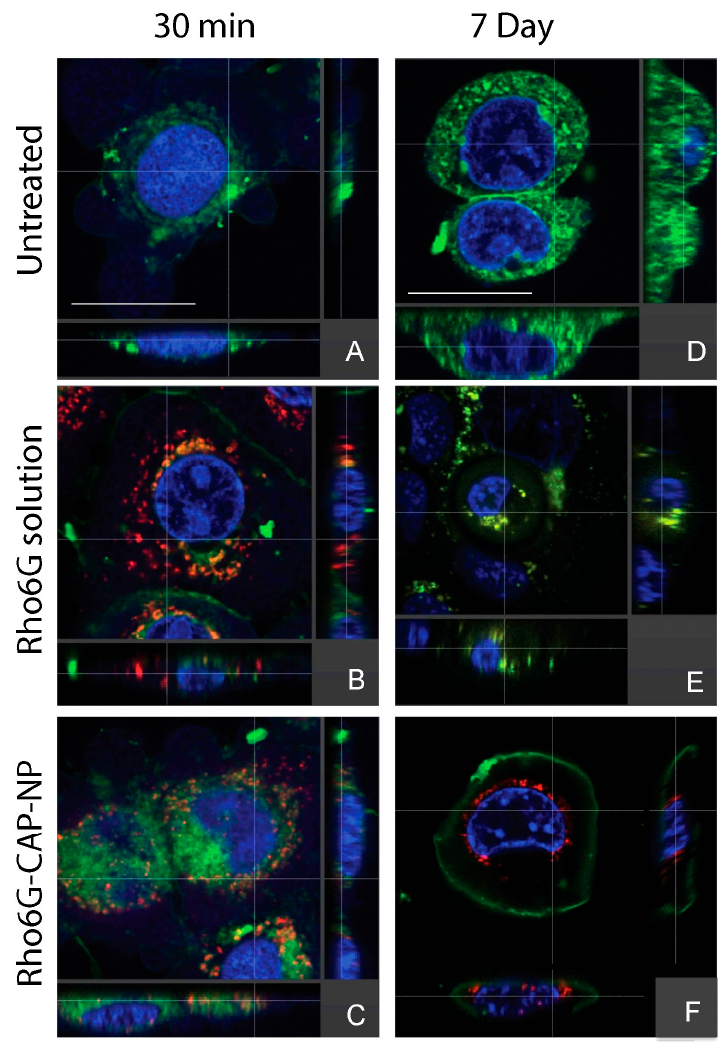
Figure 3. Translocation of Rhod6G Solution or Rhod6G–CAP–NPs to Vaginal Epithelial cells (VK2/E6E7). Rhod6G Solution (red) or Rhod6G–CAP–NPs at: 30 min ( A – C ); and seven days ( D – F ) post-treatment. Orthogonal Plane Images were obtained and evaluated by the IBIF Leica TCS SP8 MP Confocal Microscope at 63 × with 5 × computational magnification. DAPI: blue, DiO: green, Rhodamine: red. ( A )/( D ): Untreated, ( B )/( E ): Rhodamine Solution (1 µ g/mL), ( C )/( F ): Rhod6G–CAP–NPs (1 µ g/mL). Scale bar = 13 µ m and is applicable to ( B – F ). For visualization of nanoparticles in print, scale bars are omitted from ( B – F ), and contrast and brightness were enhanced using imaging software.